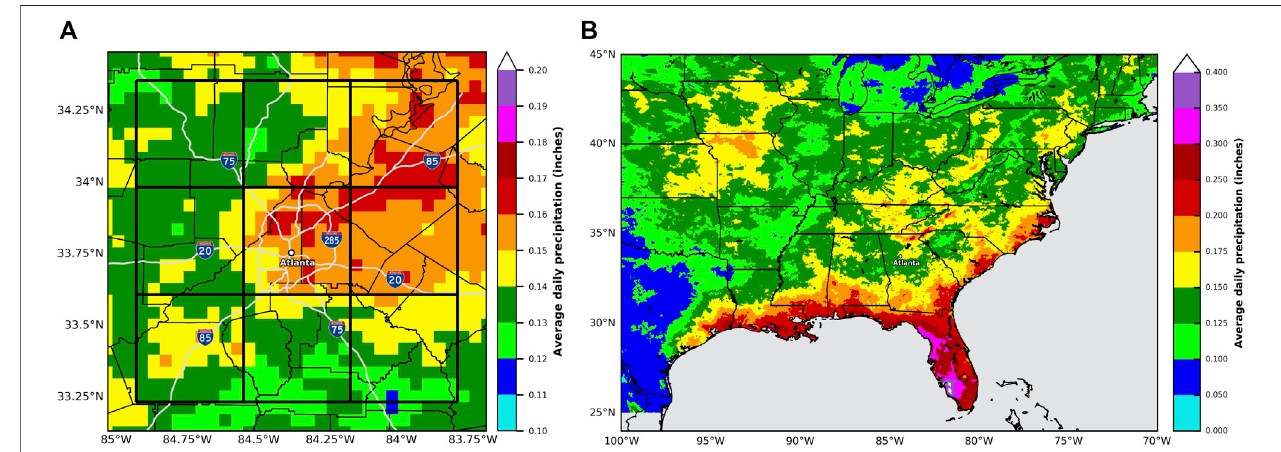
FIGURE 2 | Percentage of urban rainfall days by month and season (2002 – 2019) for the three different methods employed in this study.